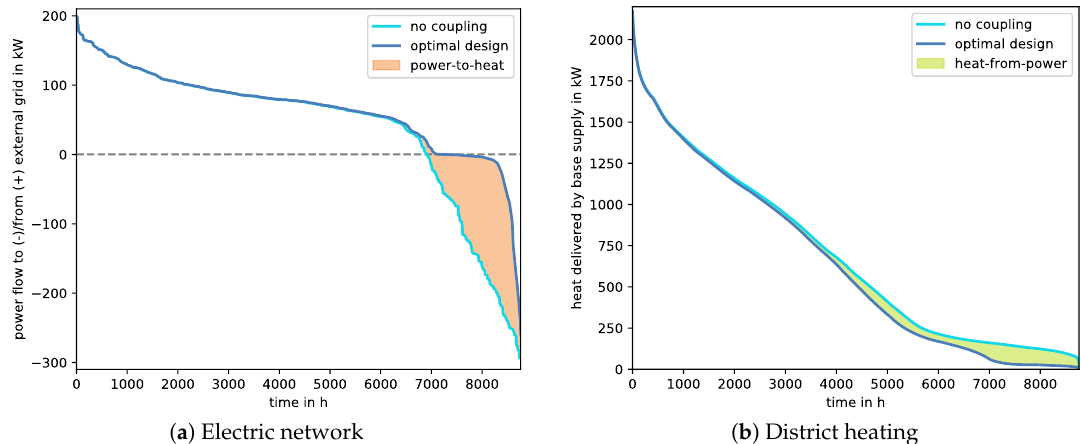
Figure 12. Load duration curves for the electric network ( a ) and the district heating network ( b ) for the uncoupled and the optimal design system